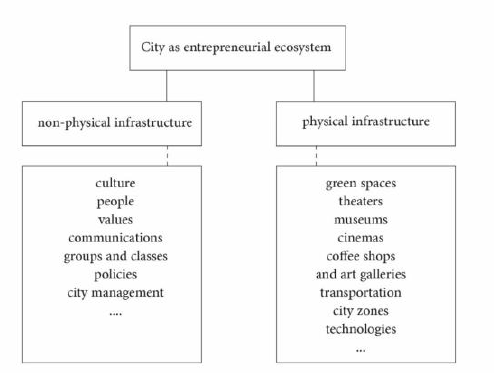
Figure 2 . City as entrepreneurial ecosystem, illustrated by